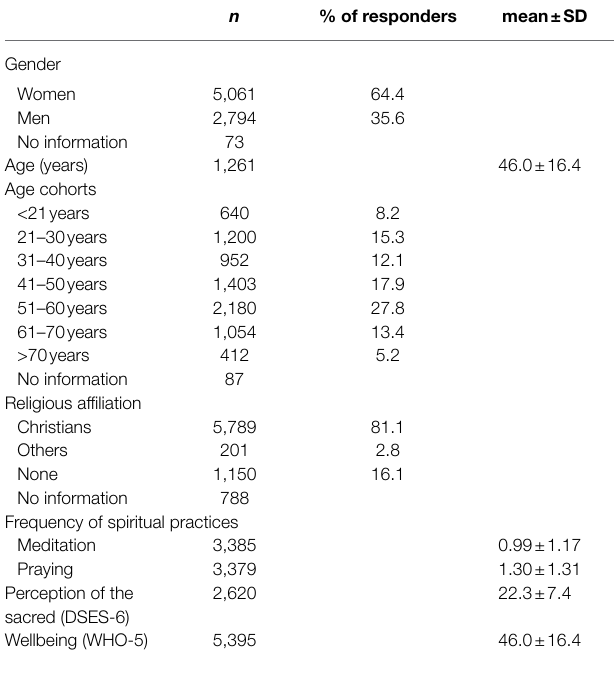
TABLE 1 | Sociodemographic data of participants ( N =